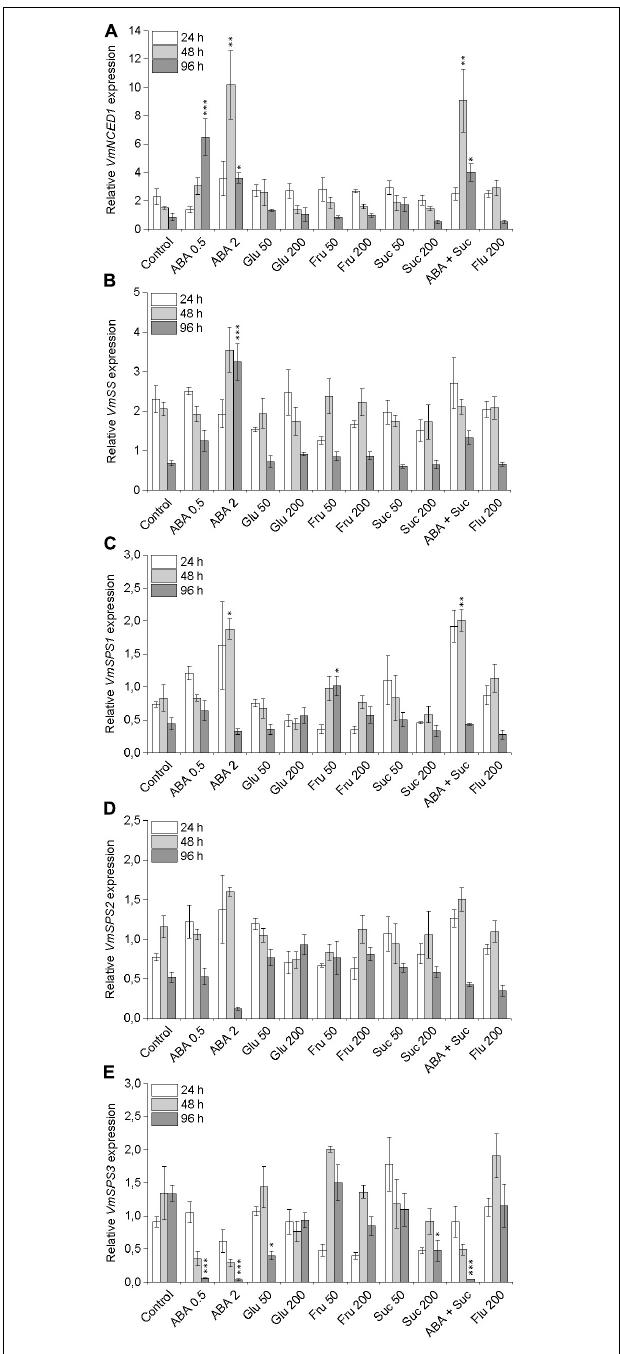
FIGURE 5 | Effect of post-harvest ABA and sugar treatments on the expression of key ABA and sucrose biosynthetic genes VmNCED1 (A) , VmSS (B) , VmSPS1 (C) , VmSPS2 (D) , and VmSPS3 (E) in bilberry fruit. The treatments were: ABA (0.5 and 2 mM), glucose (50 and 200 mM), fructose (50 and 200 mM), sucrose (50 and 200 mM), 0.5 mM ABA + 200 mM sucrose, 200 µ M fluridone or water (control). Relative expression of the genes was quantified by qRT-PCR and normalized to VmGAPDH . Values represent means ± SEs of three replicates. Asterisks indicate significant differences from respective control ( ∗ P ≤ 0.05, ∗∗ P ≤ 0.01, ∗∗∗ P ≤ 0.001, one-way ANOVA with Tukey’s HSD